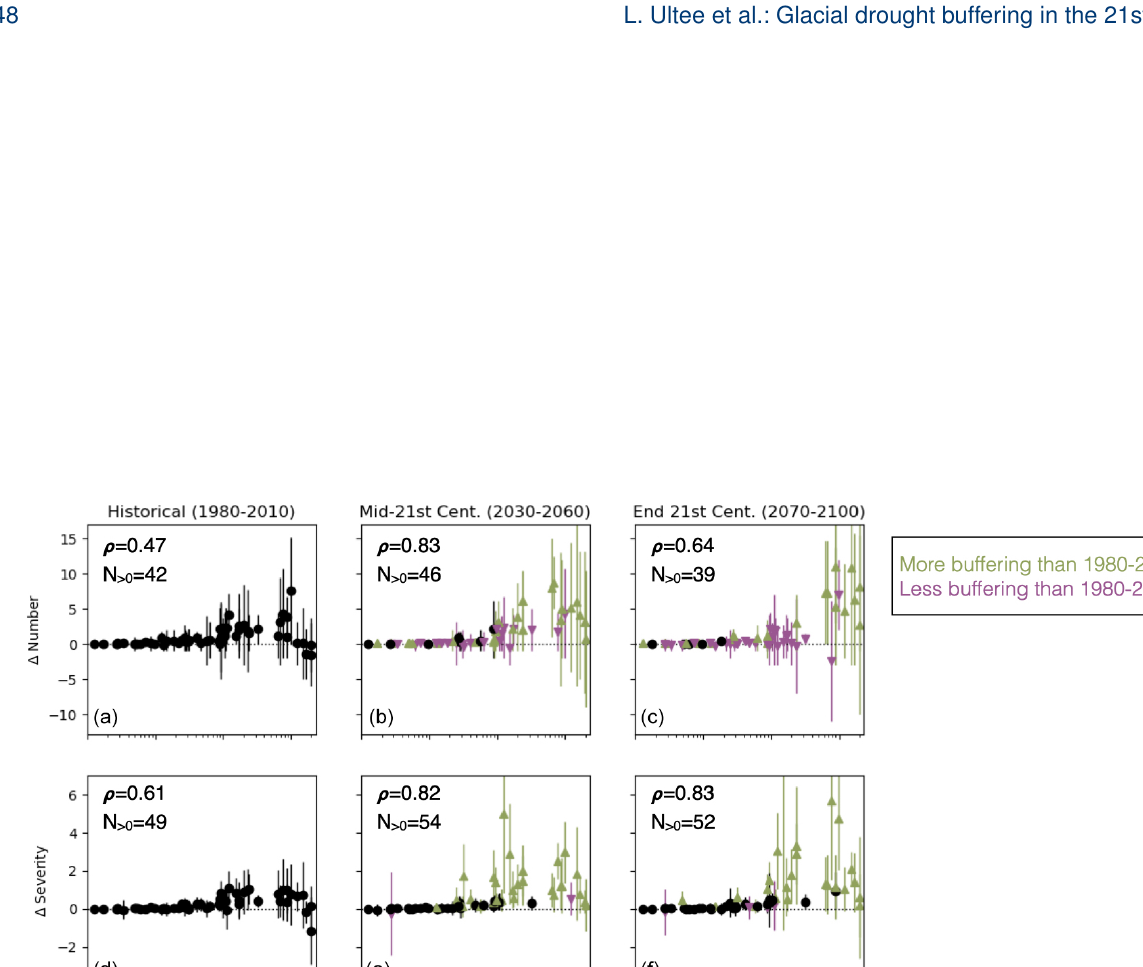
Earth Syst. Dynam., 13, 935–959,